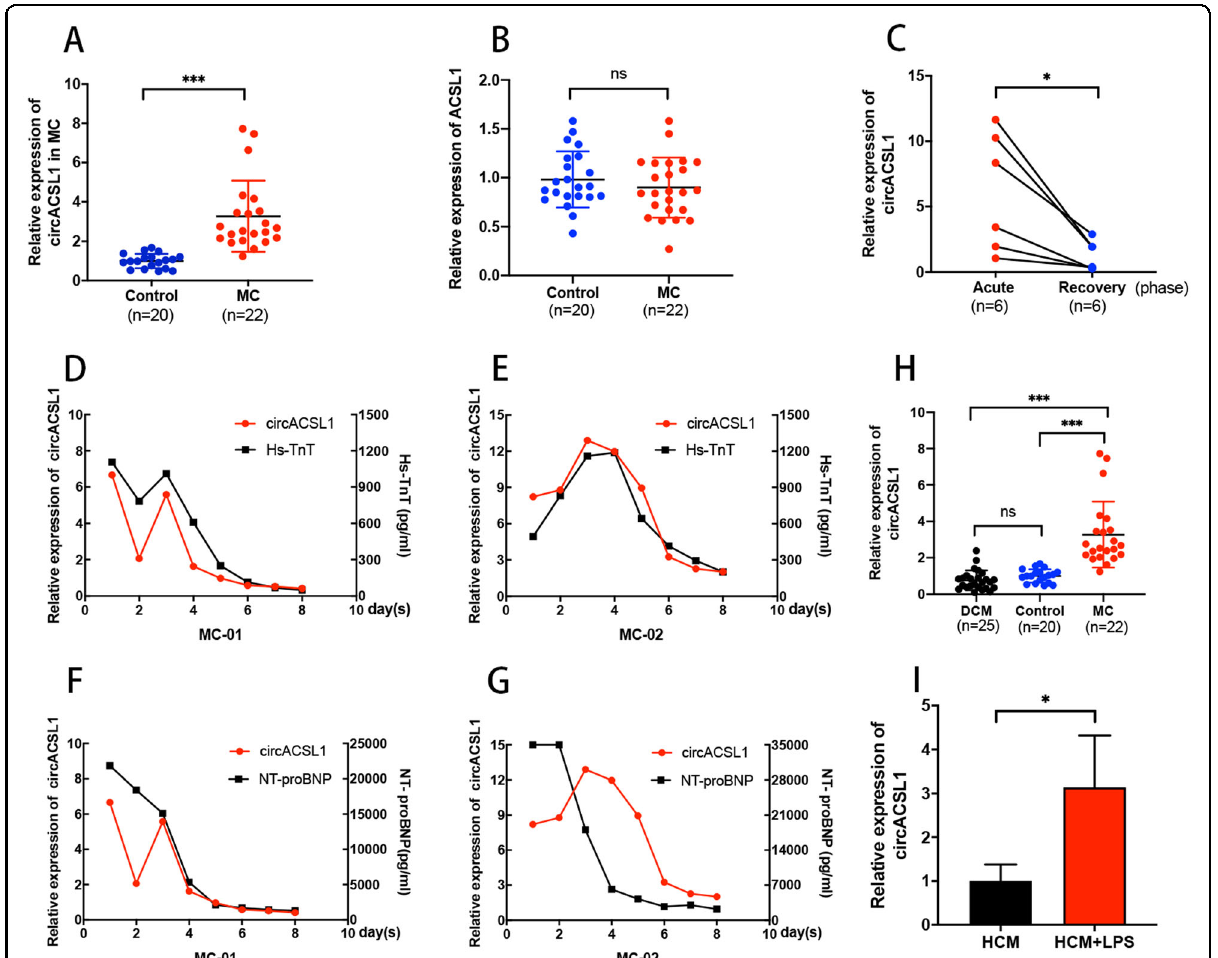
control volunteers ( n = 20) as measured by qRT-PCR. B The expression of pre-mRNA ACSL1 showed no signi fi cant difference between MC ( n = 22) and controls ( n = 20). C The expression level of circACSL1 in the recovery phase decreased signi fi cantly compared with the acute phase in six MC patients ( n = 6). D , E The dynamic changes of circACSL1 and Hs-TnT (pg/ml) levels were detected every day within the fi rst week of onset in two MC patients (MC-01 and MC-02). F , G The dynamic changes of circACSL1 and NT-pro BNP (pg/ml) levels were detected every day within the fi rst week of onset in two MC patients (MC-01 and MC-02). H The expression levels of circACSL1 in dilated cardiomyopathy (DCM) and MC. I circACSL1 was upregulated in the LPS-induced HCM in fl ammation model. Data were presented as mean ±SD. * p < 0.05; ** p < 0.01; *** p < 0.001; ns (no signi fi cance) p > 0.05 (Student ’ s t